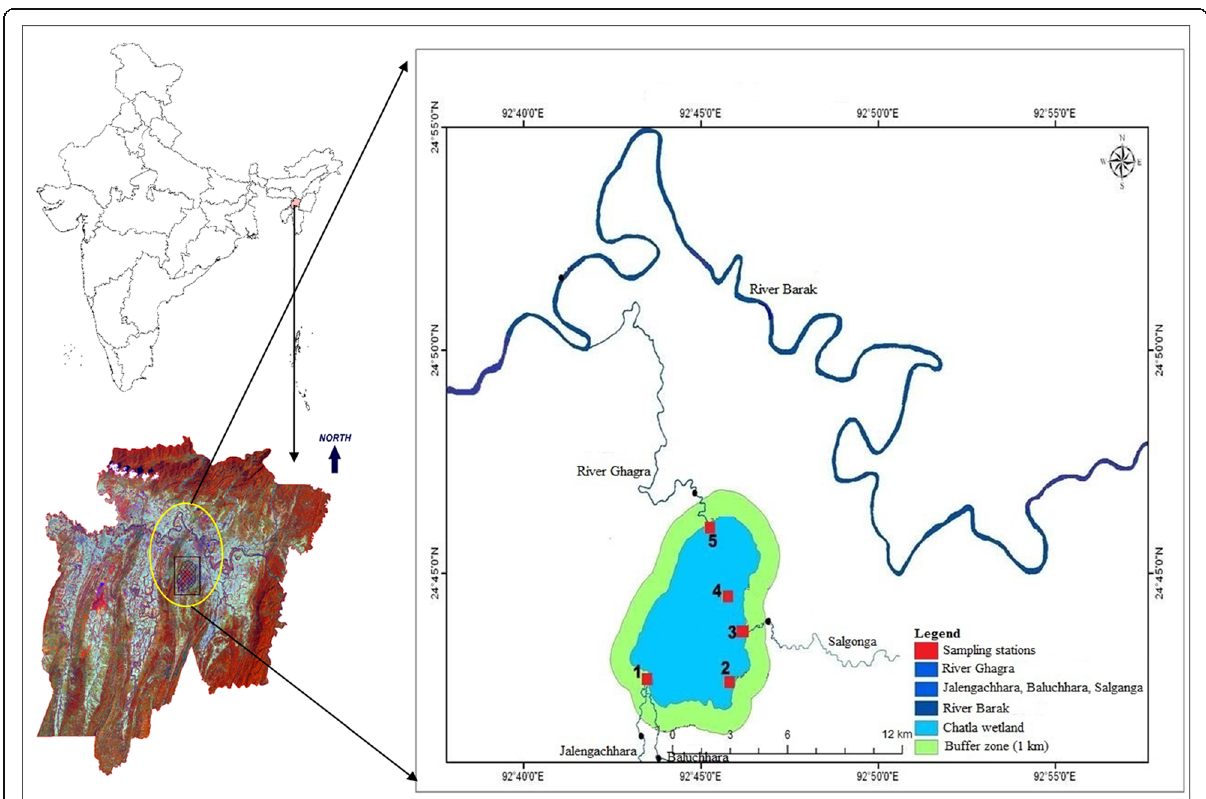
Fig. 1 Location of Chatla wetland and the sampling stations. Station 1, inlet point 1; station 2, middle point 1; station 3, inlet point 2; station 4, middle point 2; and station 5, outlet